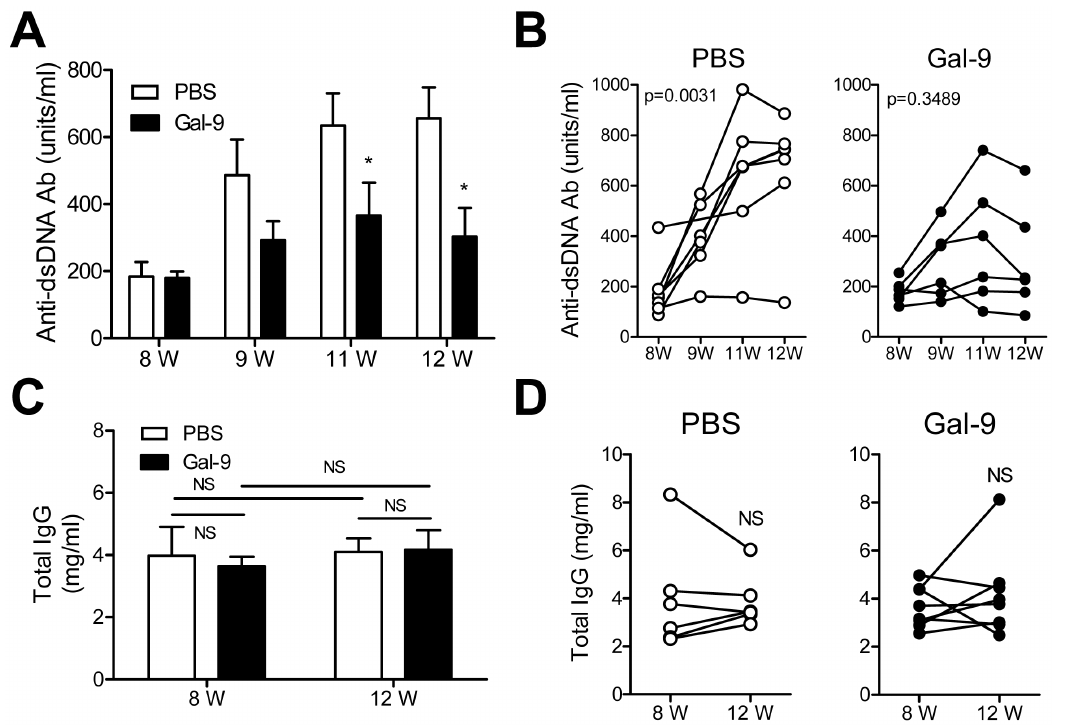
Figure 5. Effects of Gal-9 on the level of total IgG and anti-dsDNA antibody. ( A ) Comparison of anti-dsDNA antibody levels at 8, 9, 11, and 12 weeks of age between PBS-treated (n=7) and Gal-9-treated (n=6) mice. Human Gal-9 and PBS were injected intraperitoneally into 8-week-old mice 3-times/week for 4 weeks. (*, P , 0.05) ( B ) Comparison of anti-dsDNA antibody levels in 8- to 12-week-old PBS-treated (n=7) and Gal-9-treated (n=6) mice. ( C ) Comparison of total IgG levels between PBS-treated (n=7) and Gal-9-treated (n=8) mice at 12 weeks of age. Human Gal-9 and PBS were injected intraperitoneally into 8-week-old mice 3-times/week for 4 weeks. (NS, not significant) ( D ) Comparison of total IgG levels in 8- and 12- week-old PBS-treated (n=7) and Gal-9-treated (n=8) mice. (NS, not